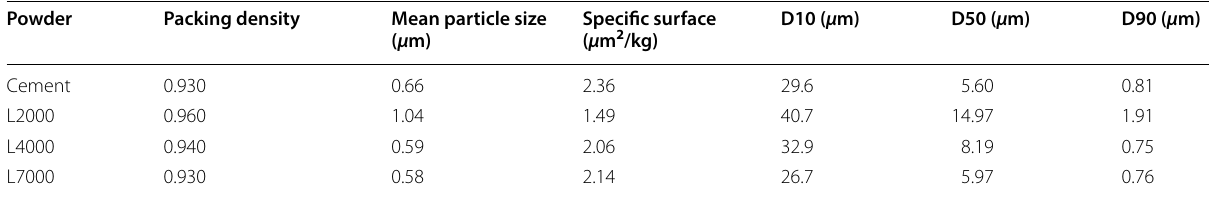
Table 3 A single powder conditions calculated using PSD.